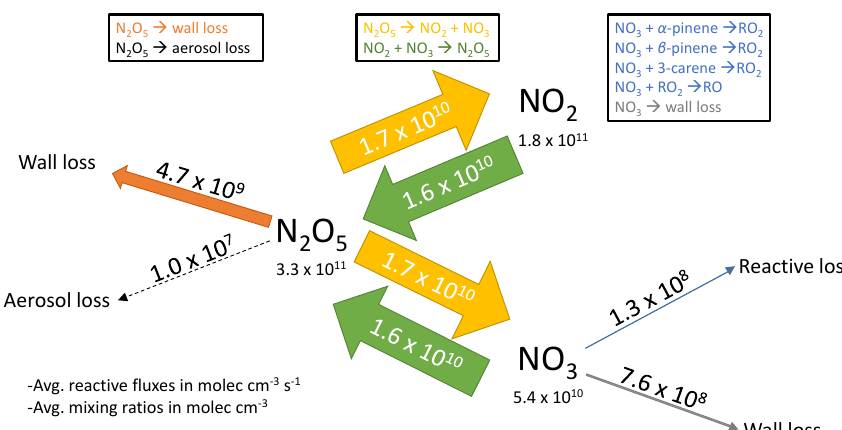
Figure 1. Typical average mixing ratios and reactive fluxes for the major reactions in the NO 3 -OFR when injecting N 2 O 5 to investigate SOA formation from NO 3 oxidation. These reactive fluxes resulted from running the model with inputs of 25 ◦ C, 50% RH, 50ppb O 3 , 2ppb NO 2 , 1.5ppb NO 3 , 50ppb N 2 O 5 , 0.75ppb total MT, and a rate constant for N 2 O 5 uptake to aerosol surfaces of 3 × 10 − 5 s − 1 . Reaction arrow widths are sized relative to their average reactive fluxes. Reactions that were included in the model (shown in Table S1 in the Supplement) but with smaller average rates are not shown